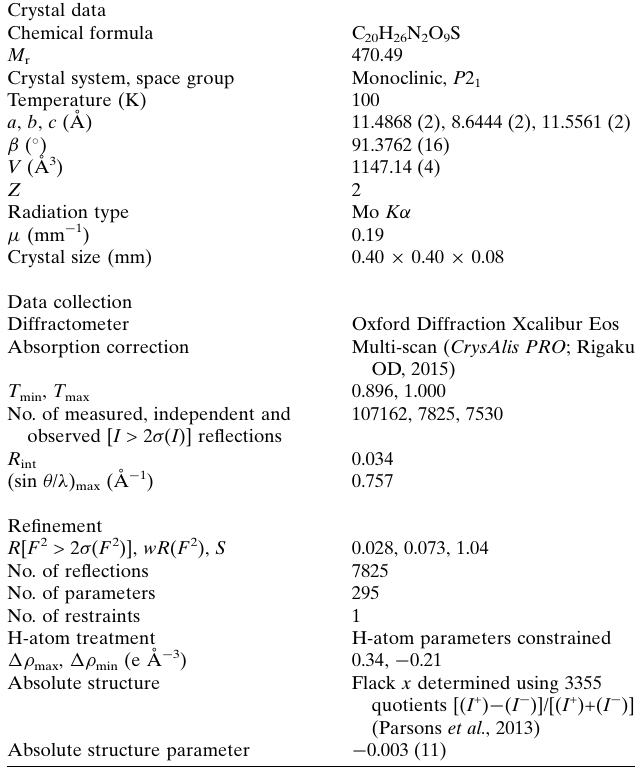
Table 3 Experimental details.